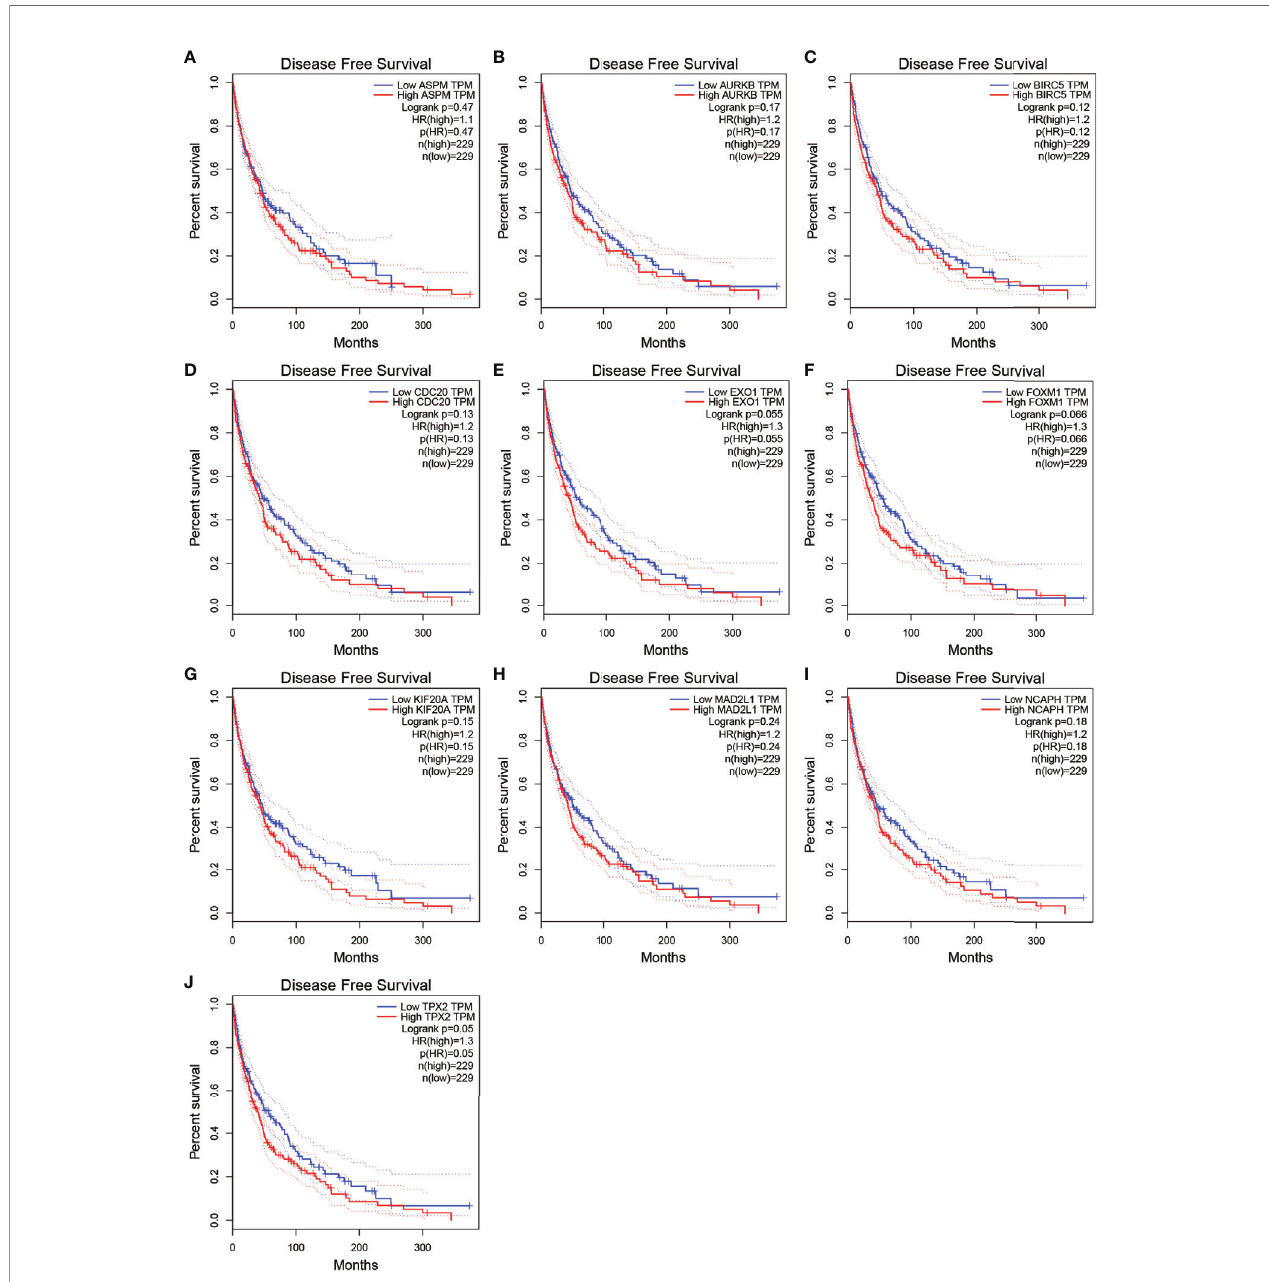
FIGURE 9 | Disease-free survival for the top 10 Hub genes. (A – J) show the curves of disease-free survival based on the GEPIA2